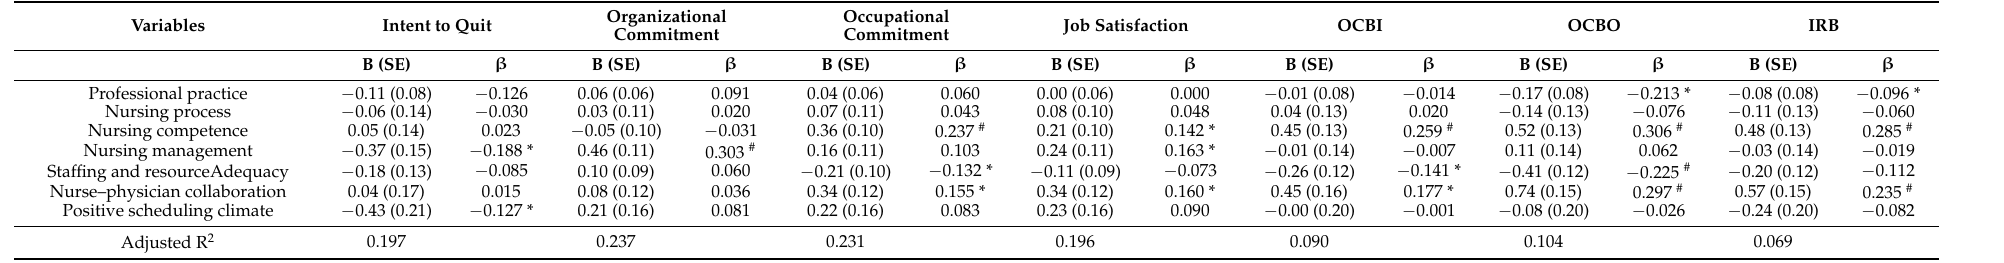
Table A3. Summary of regression analyses using the perceived nursing work environment (Choi et al., 2004) scales [5]. Variables